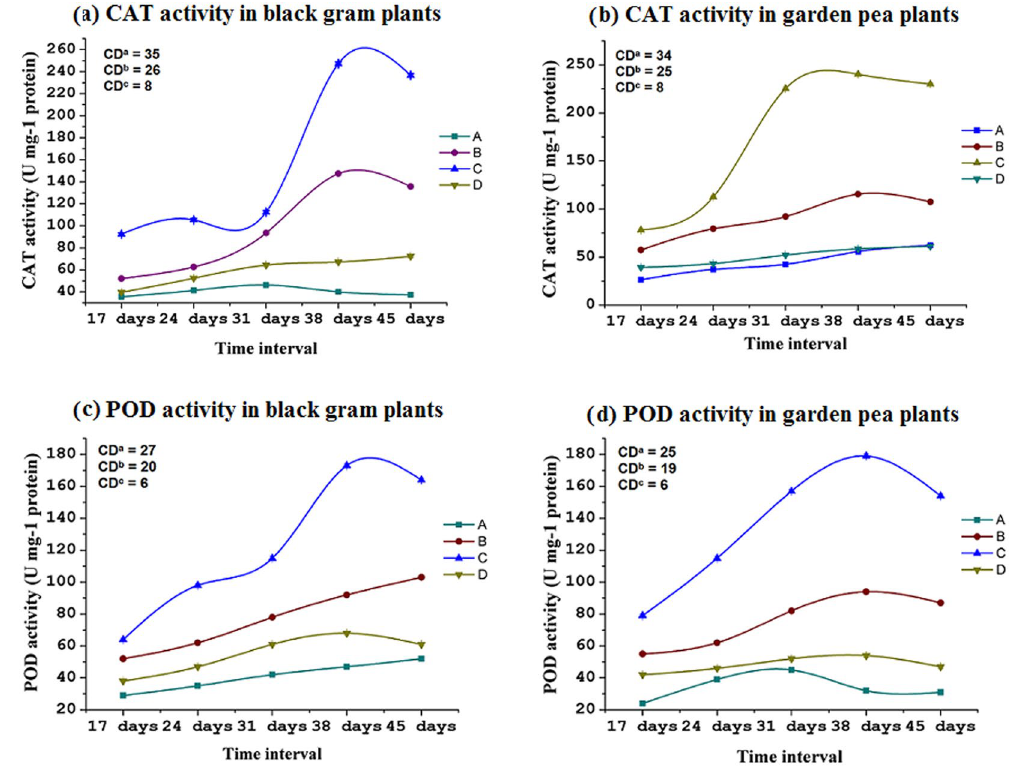
Figure 3. Activity of catalase and peroxidase in stress experienced black gram and garden pea plants in different time interval. Ten samples were analyzed for each replication, and each treatment consisted of five replications. ( a ) catalase activity in black gram, ( b ) catalase activity in garden pea, ( c ) peroxidase activity in black gram, d) peroxidase activity in garden pea. Treatments: A- uninoculated watered plants as positive control, B – consortium ( Ochrobactrum pseudogrignonense RJ12 + Bacillus subtilis RJ46 + Pseudomonas sp.RJ15) inoculated plants with drought stress induction, C- uninoculated plants under drought stress as negative control, D – consortium ( Ochrobactrum pseudogrignonense RJ12 + Bacillus subtilis RJ46 + Pseudomonas sp.RJ15) inoculated with sufficient water supply. Critical difference (CD) was computed at p = 0.05. CDa, CDb, and CDc represent critical differences for treatments, time intervals, and treatment × time intervals,